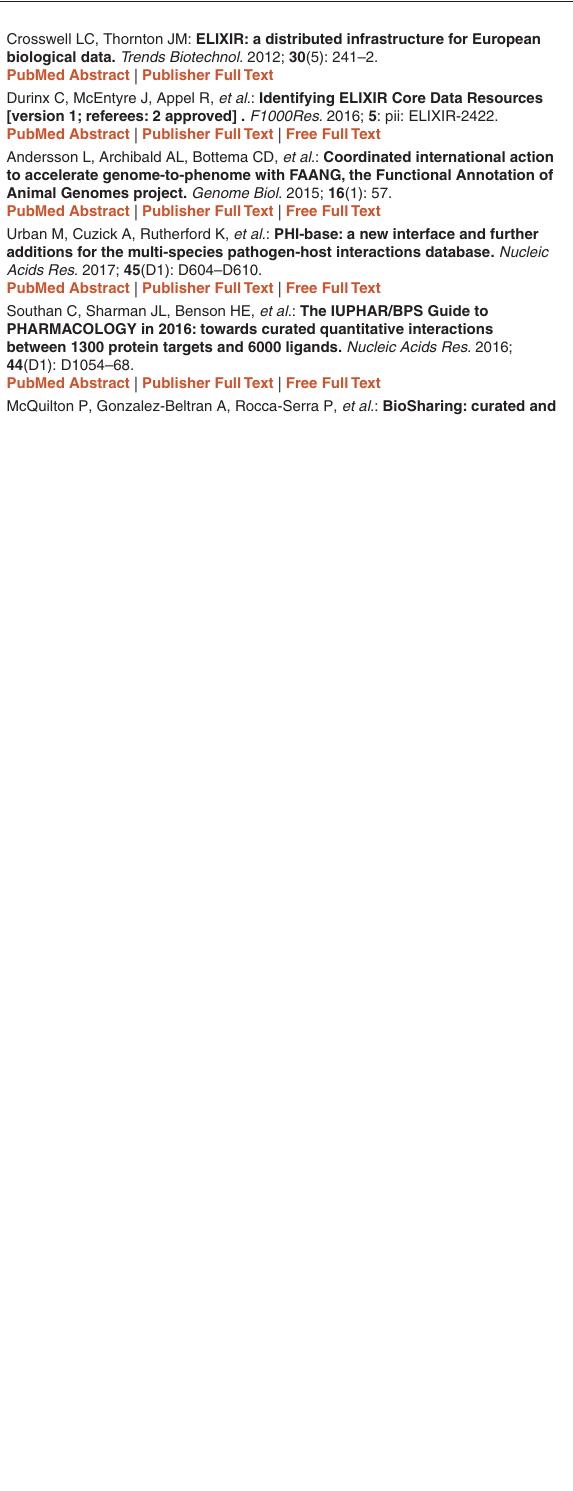
Supplementary file 1: Applicants expression of interest template form. Click here to access the